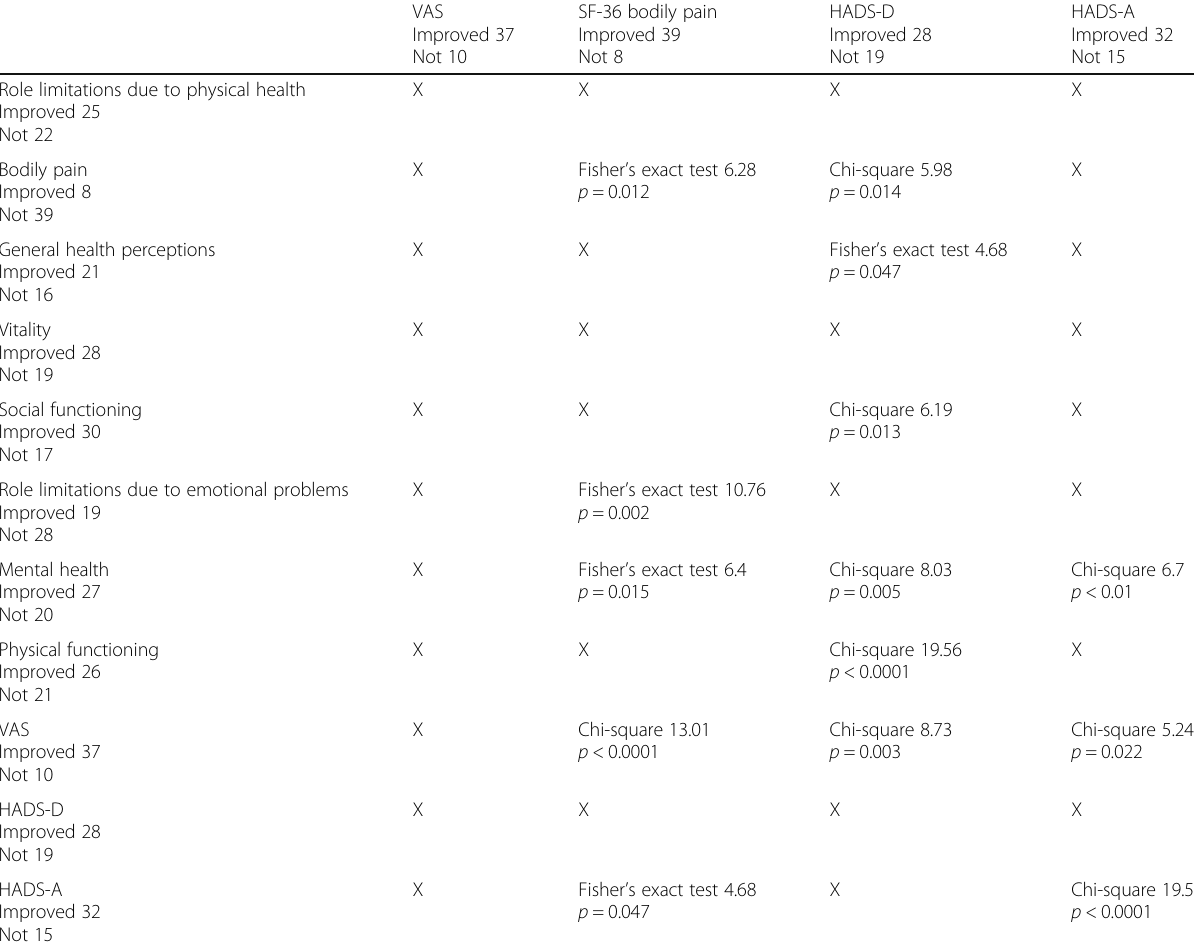
Table 3 associations among score improvements of VAS, HADS, and SF-36 domains by chi-square